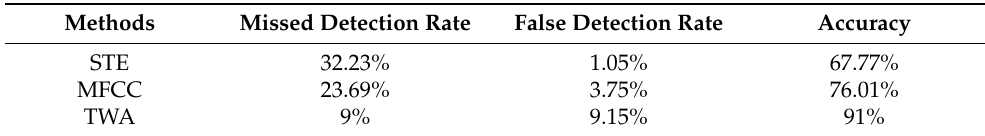
Table 2. Comparison of detection results of different